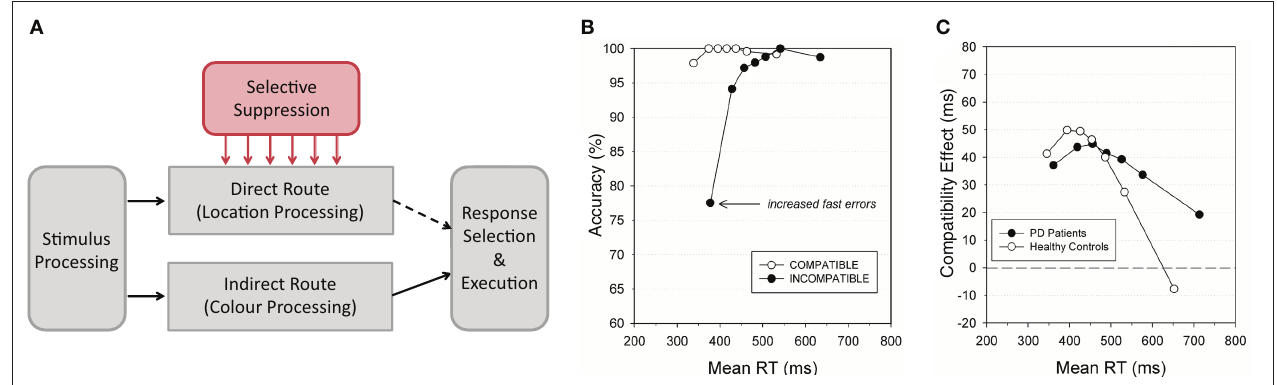
FIGURE 2 | (A) Information processing during a Simon task as modelled by the Activation-Suppression model [e.g., Ridderinkhof (2002)]. The relevant stimulus dimension (color in the Simon task) is processed via the slow, indirect, processing route. Simultaneously, irrelevant stimulus location is processed via the fast, direct, processing route. Activation of the location-based response activation is inhibited by selective suppression (shown here in red), which facilitates execution of the correct, color-based, action. The selective suppression takes time to develop, which results in a relatively high proportion of fast erroneous (location-based) responses on incongruent trials, with near-perfect response accuracy when responses are slower as the inappropriate responses have been suppressed. These effects